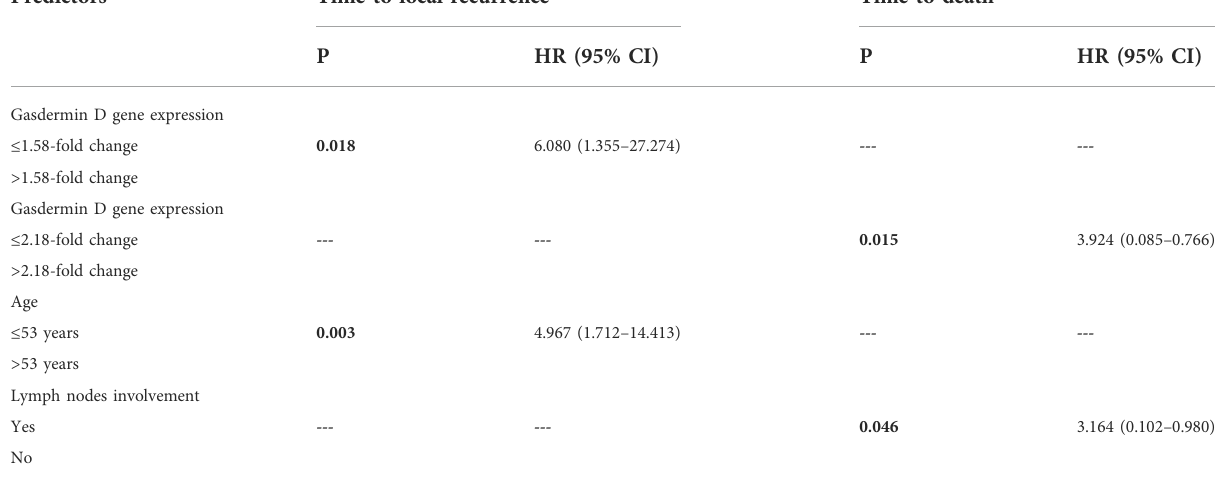
TABLE 11 Cox proportional hazards regression models: